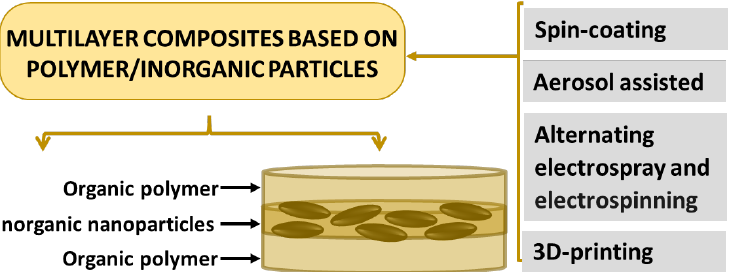
Figure 6. Multilayer composites are obtained by methods that alternate de phase’s deposition to form an object.